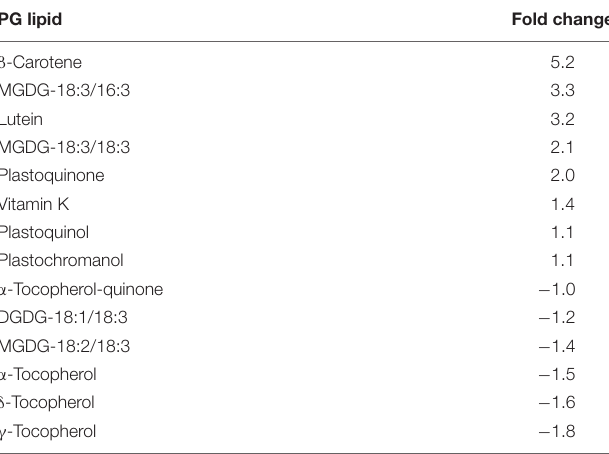
TABLE 1 | Lipid content of senescent ccd4-2 PG compared to